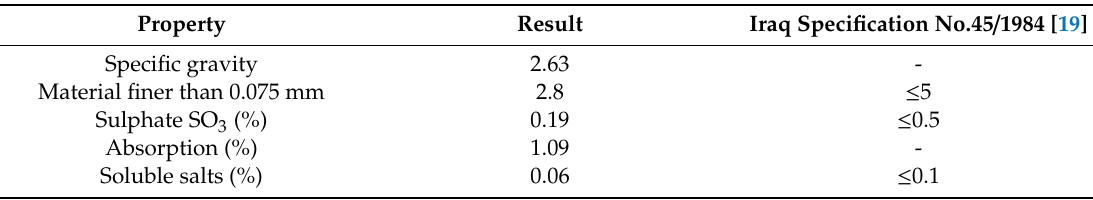
Table 2. Fine aggregate physical and chemical